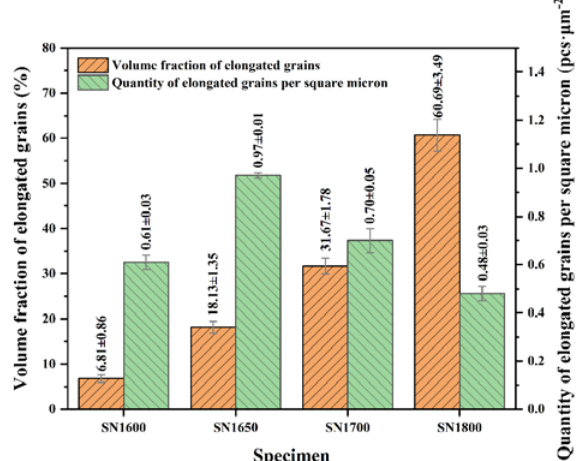
Fig. 5 Volume fractions of the elongated grains and quantities of elongated grains per square micron in the SPSed Si 3 N 4